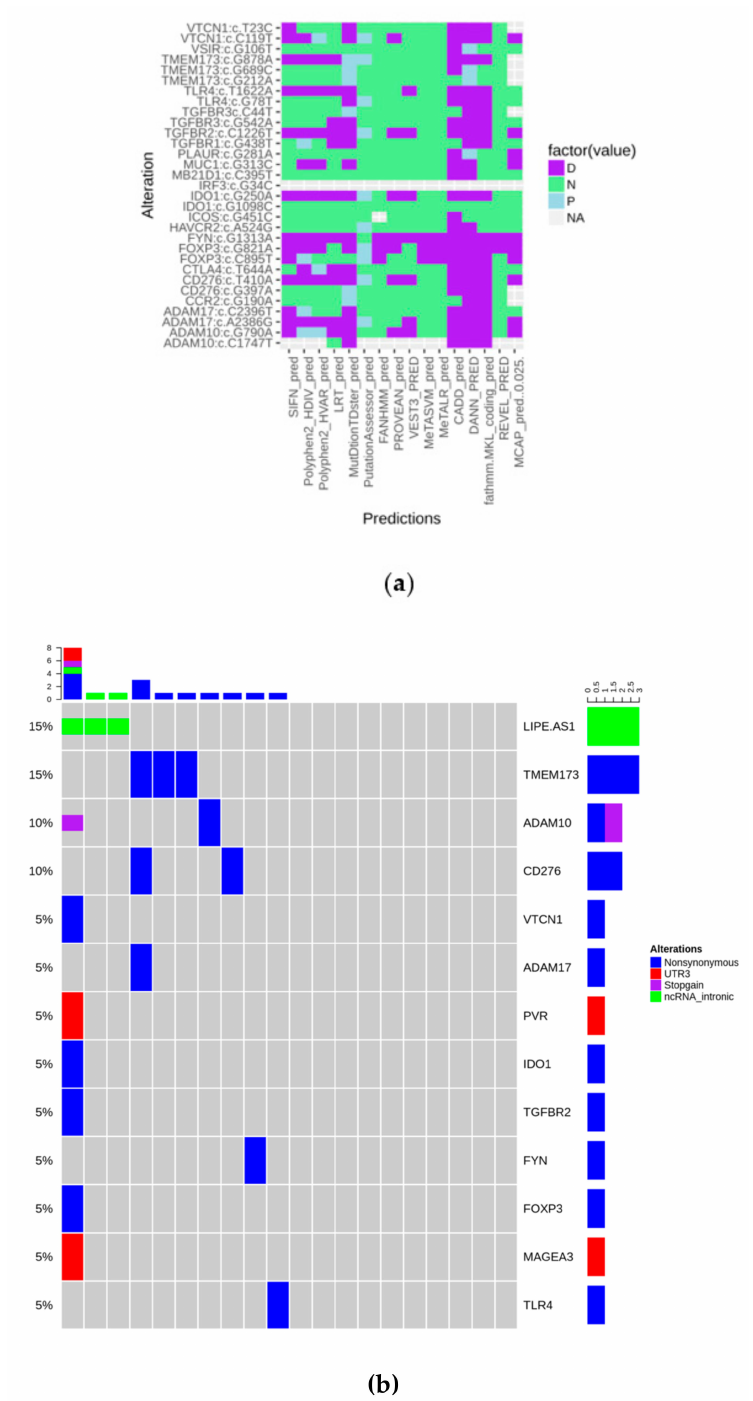
Figure 1. ( a ) Heatmap showing the predicted biological impact of detected alterations (D: Deleterious; N:Neutral; P:Predicteddeleterious); ( b